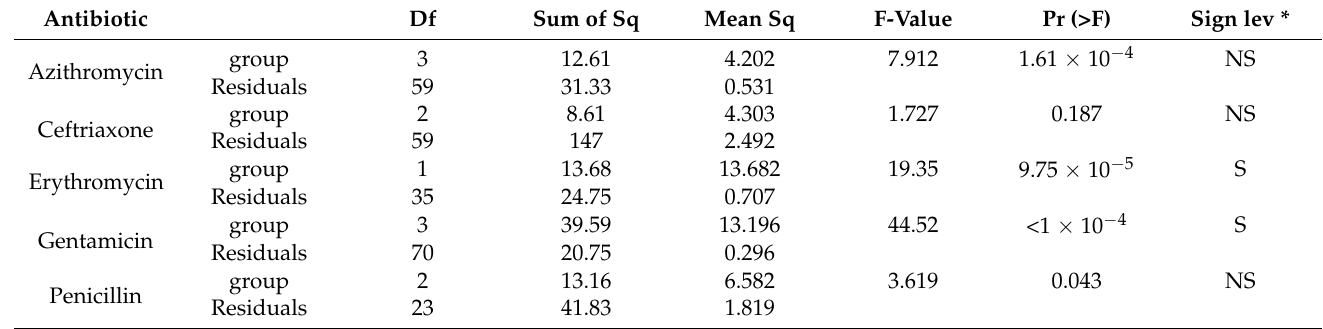
Figure 4. One-way ANOVA analysis of MIC ( µ g/mL) for each antibiotic per group (commensal, reference, N. gonorrhoeae FA19, pathogenic resistant). Scales are provided as log2. Table 3. Results of multiple pairwise comparisons of MIC means for 3 groups (commensal, reference, pathogenic) for each